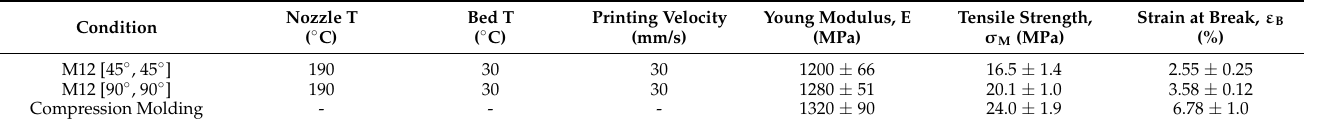
Table 8. Mechanical properties of the 3D pattern printed at different raster angles compared with the patterns obtained from compression